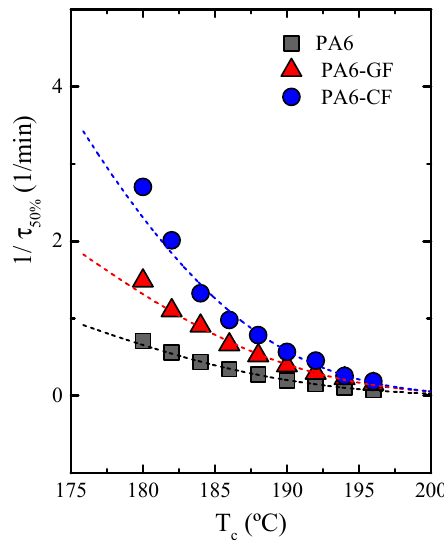
Figure 7. Inverse of the half-crystallization time as a function of crystallization temperature, for the indicated samples, neat PA6 and the PA6-GF and PA6-CF fiber composites. The solid lines correspond to fits of the LH model.